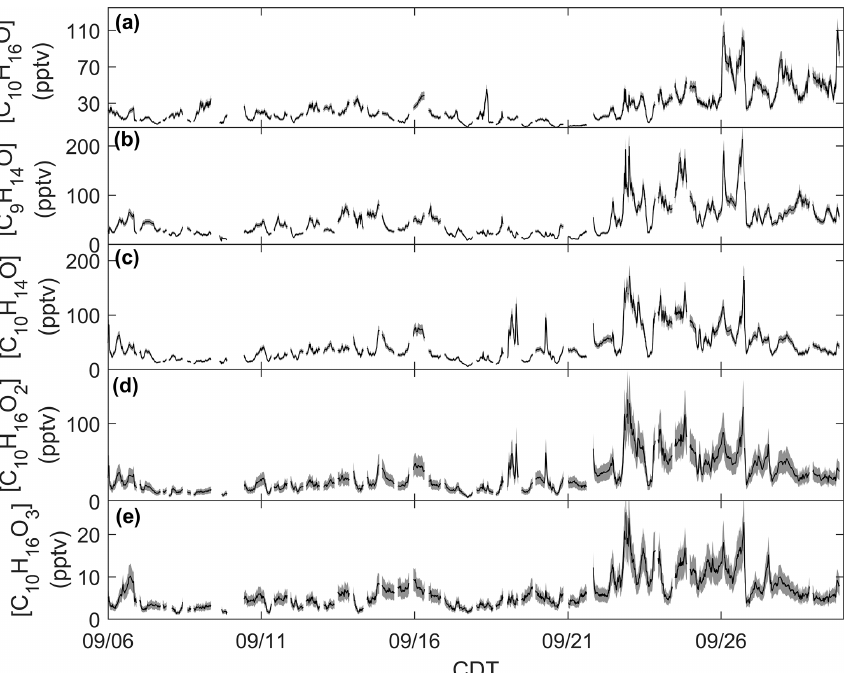
Figure 3. Time series of monoterpene oxide concentrations: (a) C 10 H 16 O calibrated for camphor, (b) C 9 H 14 O calibrated for nopinone, (c) C 10 H 14 O calibrated for thymol, and (d) C 10 H 16 O 2 and (e) C 10 H 16 O 3 calibrated for cis-pinonic acid. Measurement uncertainties are presented as shaded